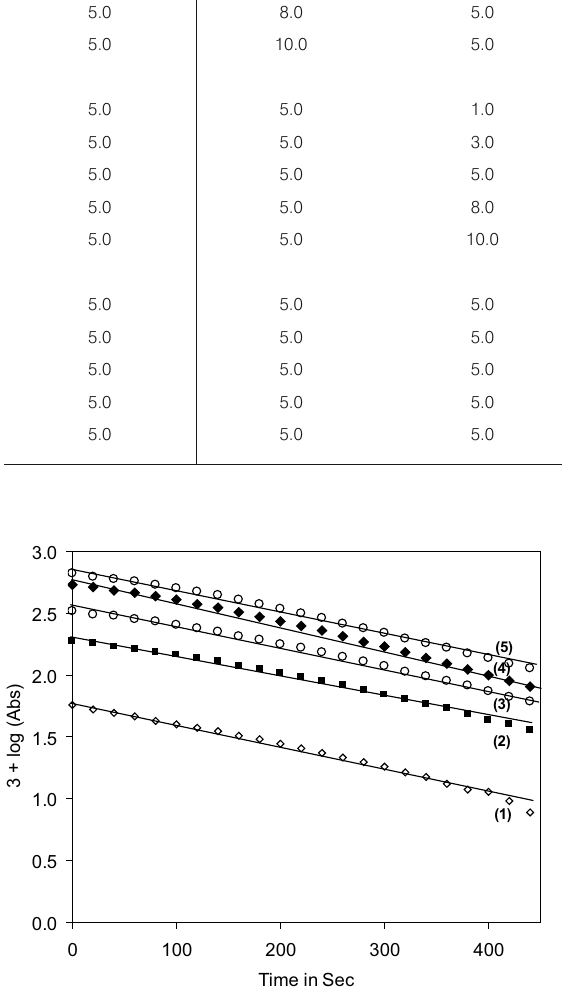
Figure 3. First order plots for the oxidation of L-tyrosine by DPC in aqueous alkaline medium at 298.1 K [DPC]×10 5 (mol dm -3 ); (1) 1.0; (2) 3.0; (3) 5.0; (4) 7.0; (5) 10.0.